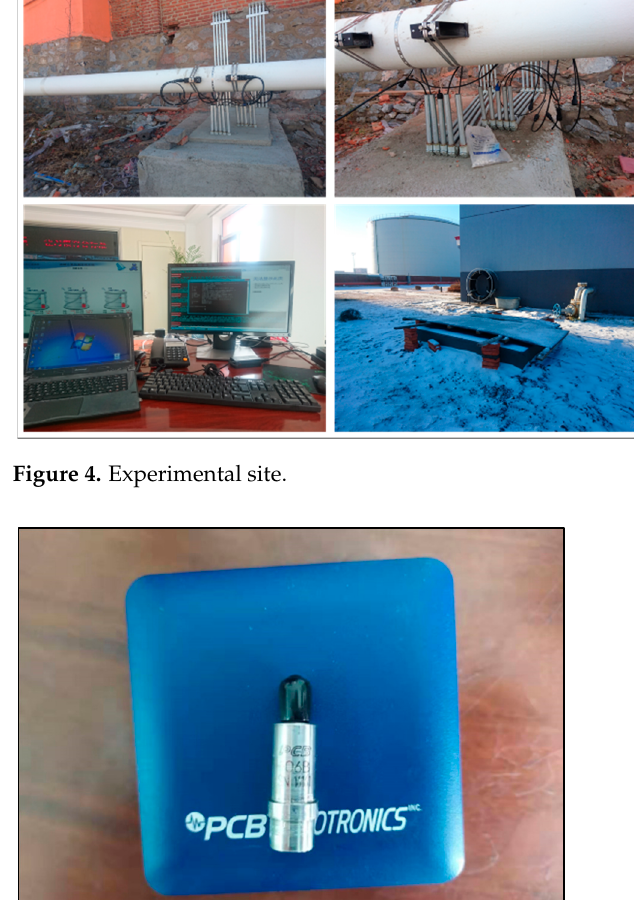
Figure 3. Experimental schematic.